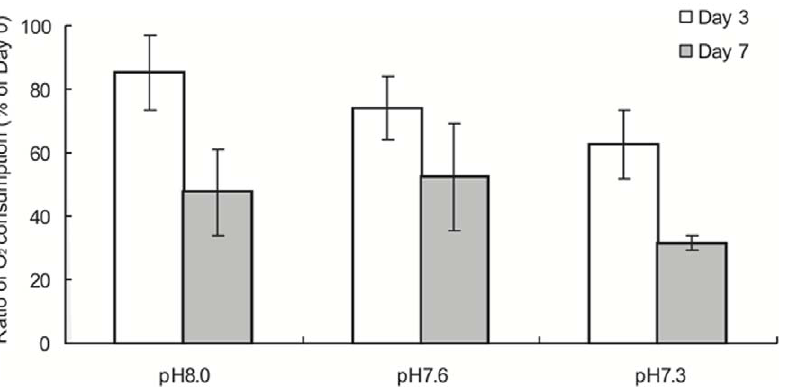
Figure 3. Metabolic rate of planula larvae of Acroporadigitifera . Oxygen consumption ( m mol planula 2 1 h 2 1 ) of the larvae after 3 d (Day 3) and 7 d (Day 7) relative to that measured before the initiation of theexperiment (Day 0) was compared among three different pH conditions. Bars indicate means and standard errors ( n =5).